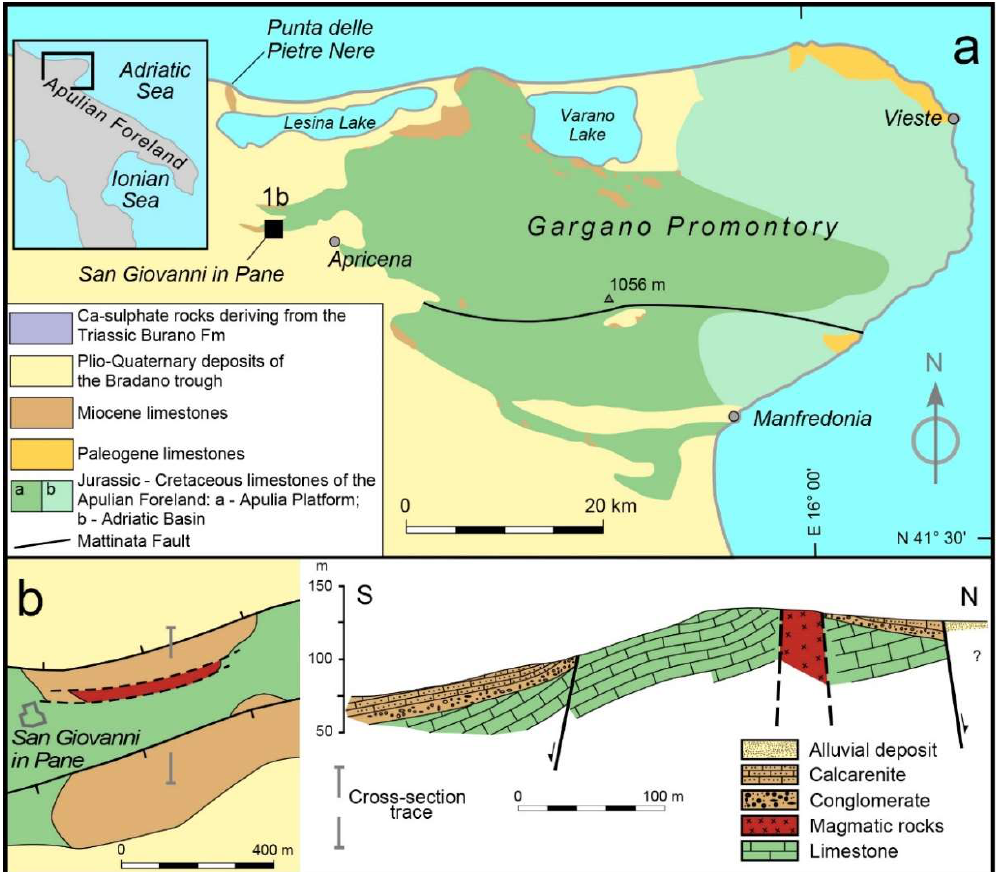
Figure 1. ( a ) Geological sketch map showing the location of the Punta delle Pietre Nere and San Giovanni in Pane mafic and ultramafic rocks in the context of northern Apulian foreland; ( b ) geological sketch map of the San Giovanni in Pane area (left) and related cross-section (right) modified from the study of Carella [38].